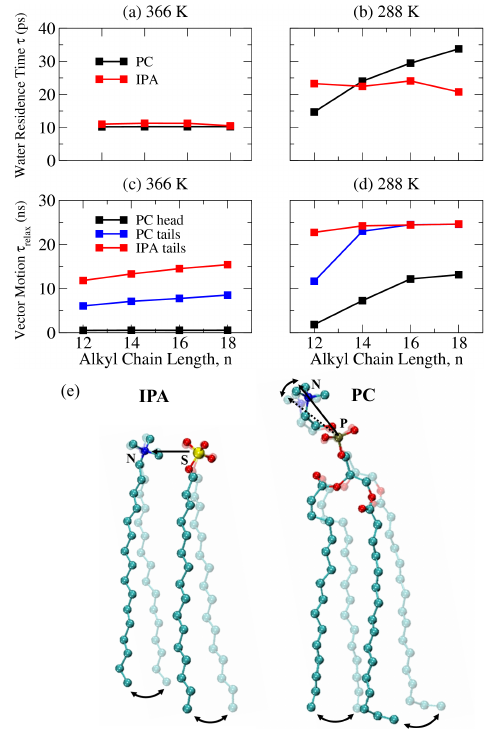
Figure 10. Water residence time τ at ( a ) 366 and ( b ) 288 K for DC n PC and C n TMA-C n S IPA bilayers with various alkyl chain lengths. The orientational relaxation time τ relax at ( c ) 366 and ( d ) 288 K for the hydrophilic heads (P–N vectors) and the hydrophilic tails of PC and the alkyl chains of IPA. ( e ) Illustrations of the couplings between the alkyl tilting and the dipole of hydrophilic groups for an IPA complex and a PC molecule. Atomic color codes are: nitrogen in blue, sulfur in yellow, phosphorus in brown, oxygen in red, and carbon in turquoise,